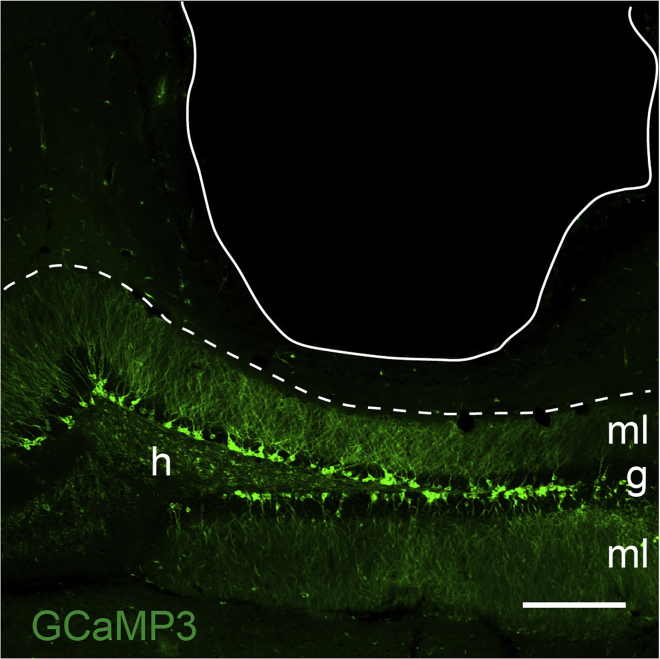
Histological confirmation of GRIN lens position and GCaMP3 signalThe letters g, h, and ml indicate the granule cell layer, hilus, and molecular layer of the DG, respectively. The white line indicates the position of the lens, and the white dotted line indicates the border between the DG and stratum lacunosum moleculare. The expression of GCaMP3 is shown in green. Scale bar, 100 μm.